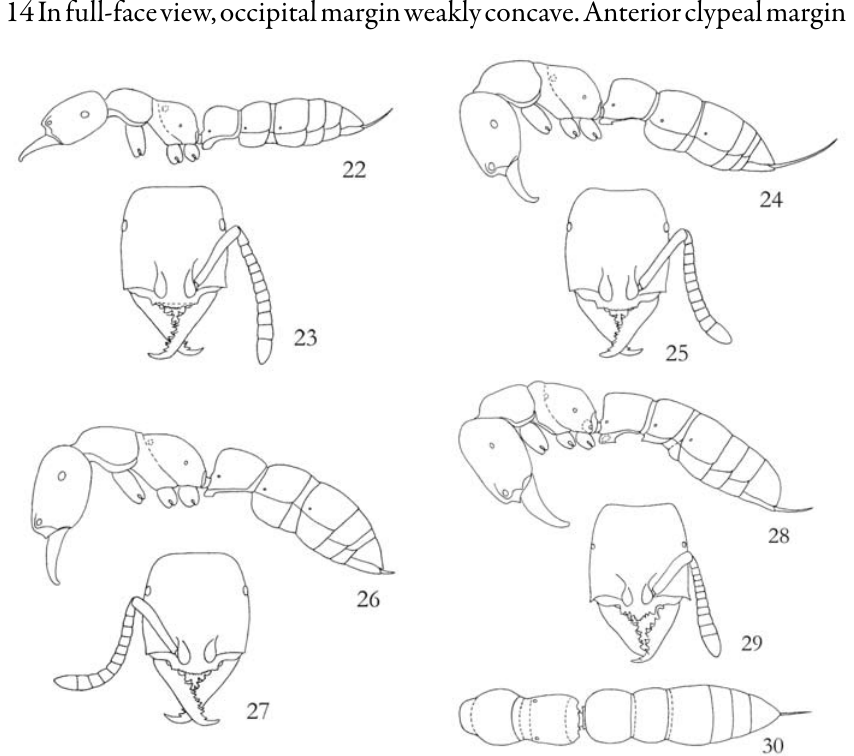
Figs. 22-30. 22-23: Worker of Amblyopone feae (Emery); 22. Head and body in profile view; 23. Head in full-face view. (Drawn from Antweb images) 24-25: Worker of Amblyopone crenata Xu; 24. Head and body in profile view; 25. Head in full-face view. (Drawn from Antweb images). 26-27: Worker of Amblyopone rothneyi Forel; 26. Head and body in profile view; 27. Head in full-face view. (Drawn from Antweb images). 28-30: Worker of Amblyopone zoma sp. nov.; 28. Head and body in profile view; 29. Head in full-face view; 30. Body in dorsal